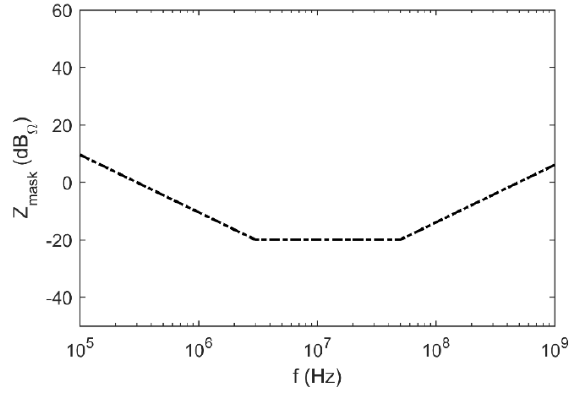
Figure 5. Z mask delineating the upper limit for the input impedance Z in of the board.